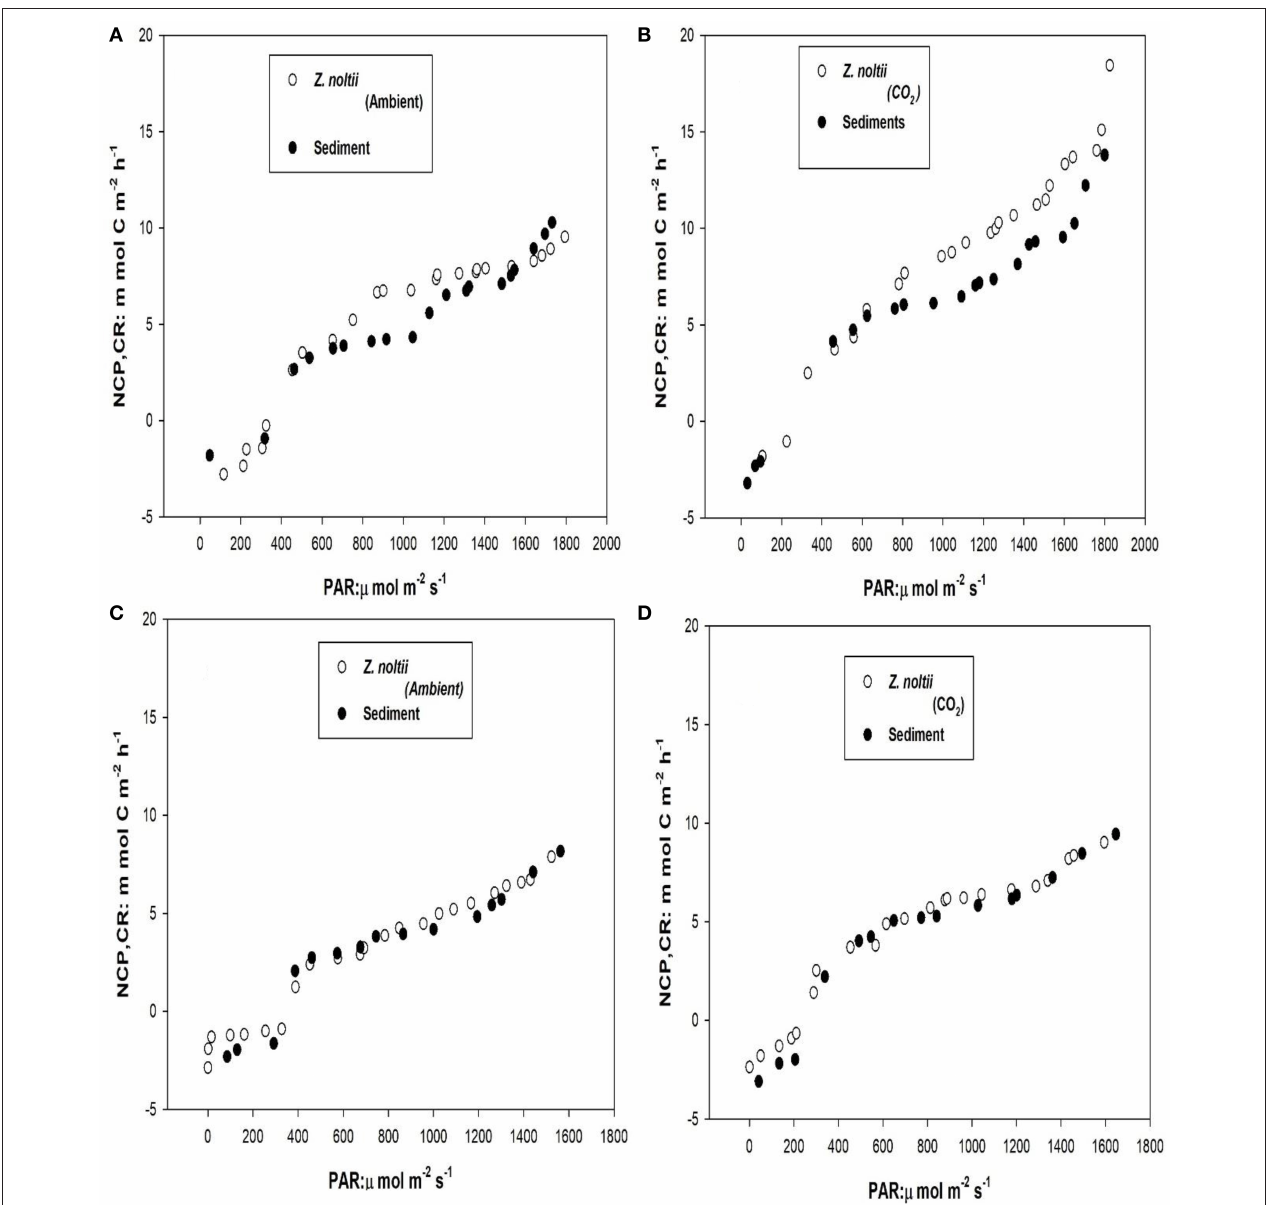
FIGURE 4 | Comparison of net community production (NCP) and respiration (NCP at 0 light level) of Z. noltei and unvegetated sediment in summer (A,B) and winter seasons (C,D) under ambient and CO 2 enriched conditions.